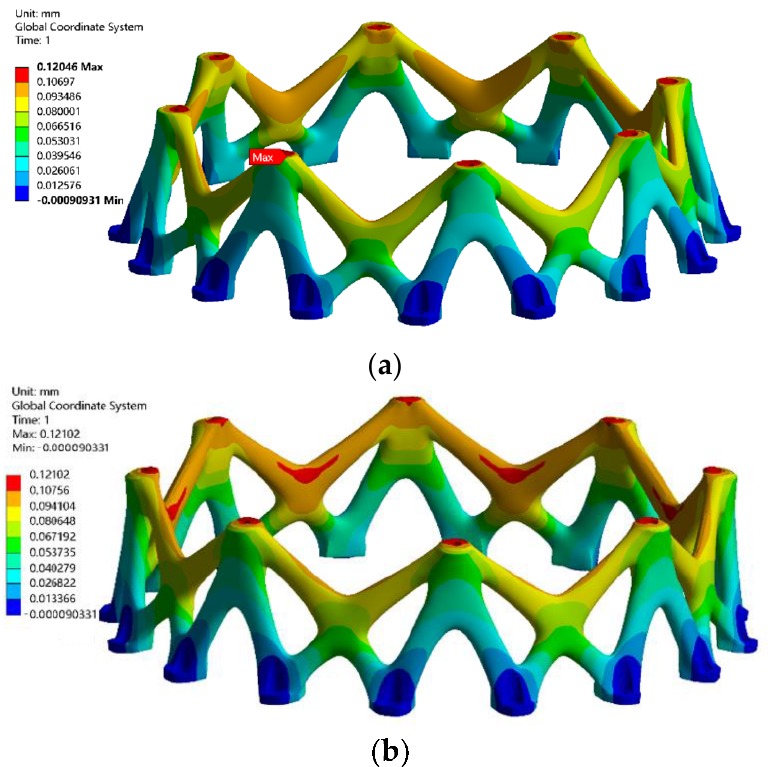
Figure 14. Displacement distribution: ( a ) The detailed model; ( b ) The homogenization model.